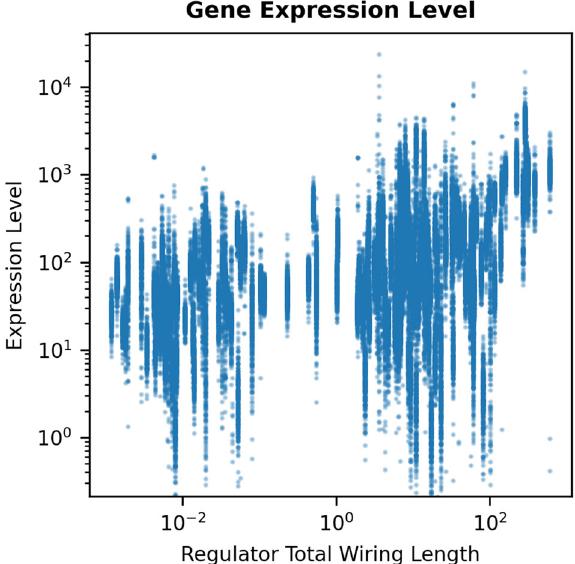
Fig. 4 Scatterplot of the expression levels of the regulator genes as a function of total wiring length of outgoing edges from each regulator gene to all its target nodes (regulator total wiring length). The gene expression levels positively correlate with the regulator total wiring lengths (average Spearman correlation across all RNA-seq datasets (see Methods): 0.4165; average p value: 1.31 × 10 − 6 ; maximal p value: 1.18 × 10 − 4